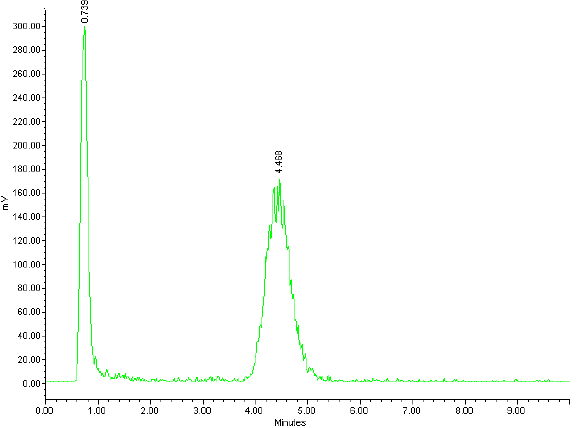
Figure 6. Radio-HPLC chromatogram of the reaction mixture of [ 68 Ga]NOTA-OL/POPC liposomes. A similar result was obtained from radio-TLC analysis, showing two well-separated peaks corresponding to unreacted 68 Ga 3+ (eluted with the solvent front) and labelled liposomes (at the baseline).